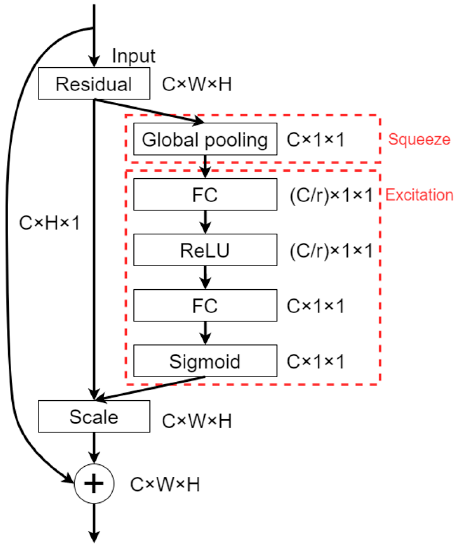
Figure 13. Schematic diagram of SE adding attention mechanism.